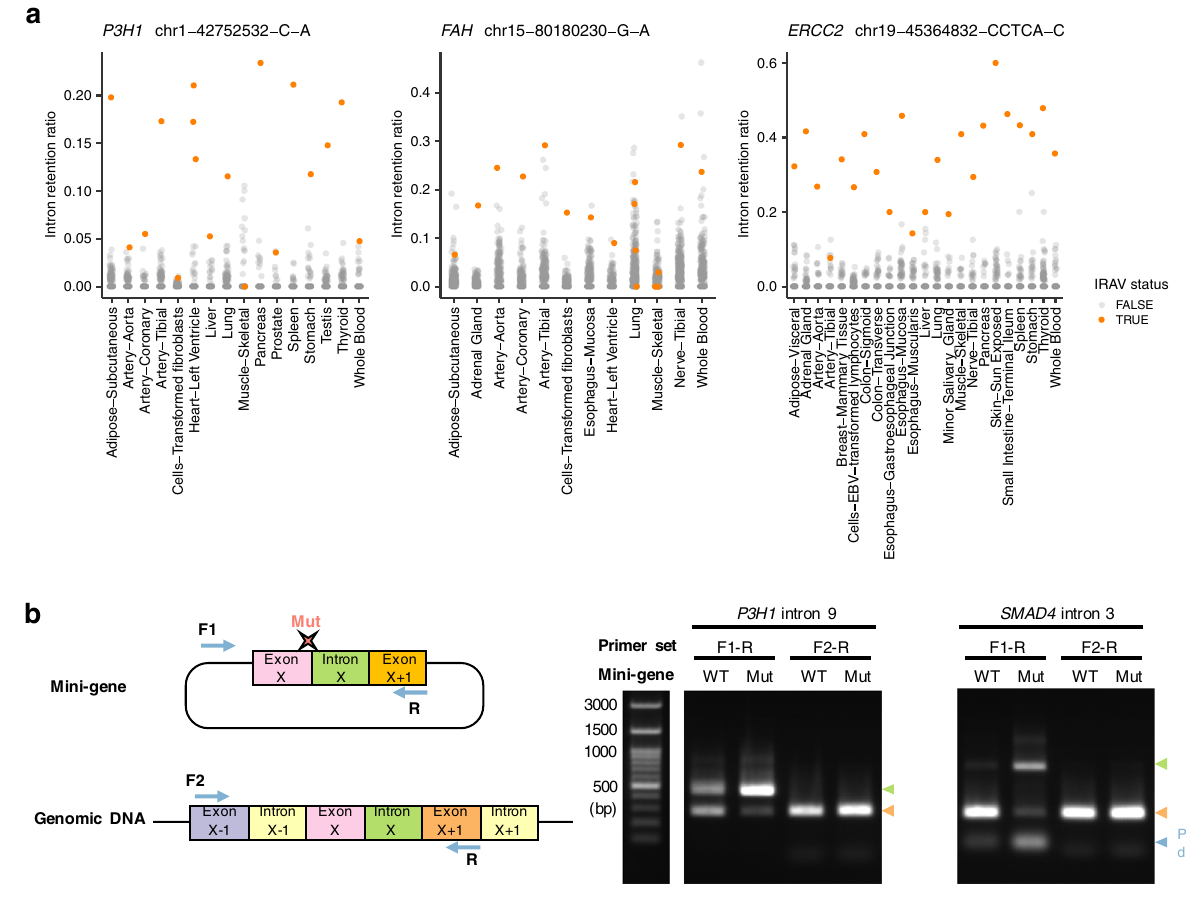
Fig. 6 | Validationofrelativelycommon IRAVsimplicatedin genetic disorders. a Relative ratios of corresponding intron retention for samples with (orange) and without (gray) the IRAVs across tissues measured using GTEx transcriptome data. The p -values measuring the differences of the intron retention ratios between sampleswithand withoutIRAVsviatheone-sidedWilcoxonrank-sum test foreach tissue and integration by Fisher ’ s method were 1.82×10 − 42 , 2.91 ×10 − 7 , and